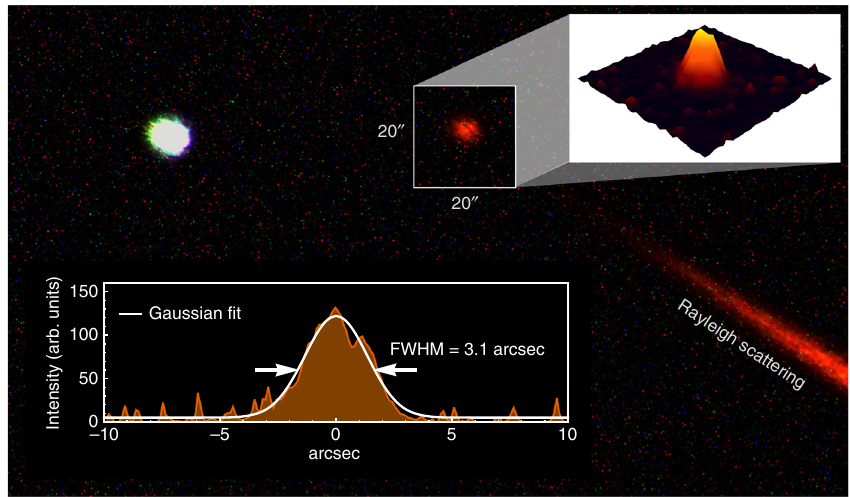
Fig. 2 Fluorescence of mesospheric sodium. A fi ve-second-exposure raw image of the sodium fl uorescence spot in the mesosphere along with the star HIP113889 obtained with the CMOS camera of the receiver telescope. The estimated long-term spot size is 3.1 arcsec, which comprises broadening due to atmospheric propagation and focusing error of the receiver telescope. Rayleigh scattering from the laser propagation in lower layers of the atmosphere is visible in the bottom-right corner of the